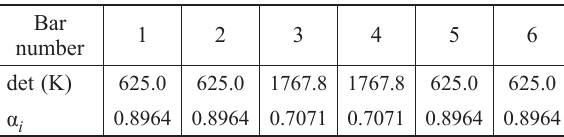
Table 3. Results of planar trusses with different support conditions as in Figure 2